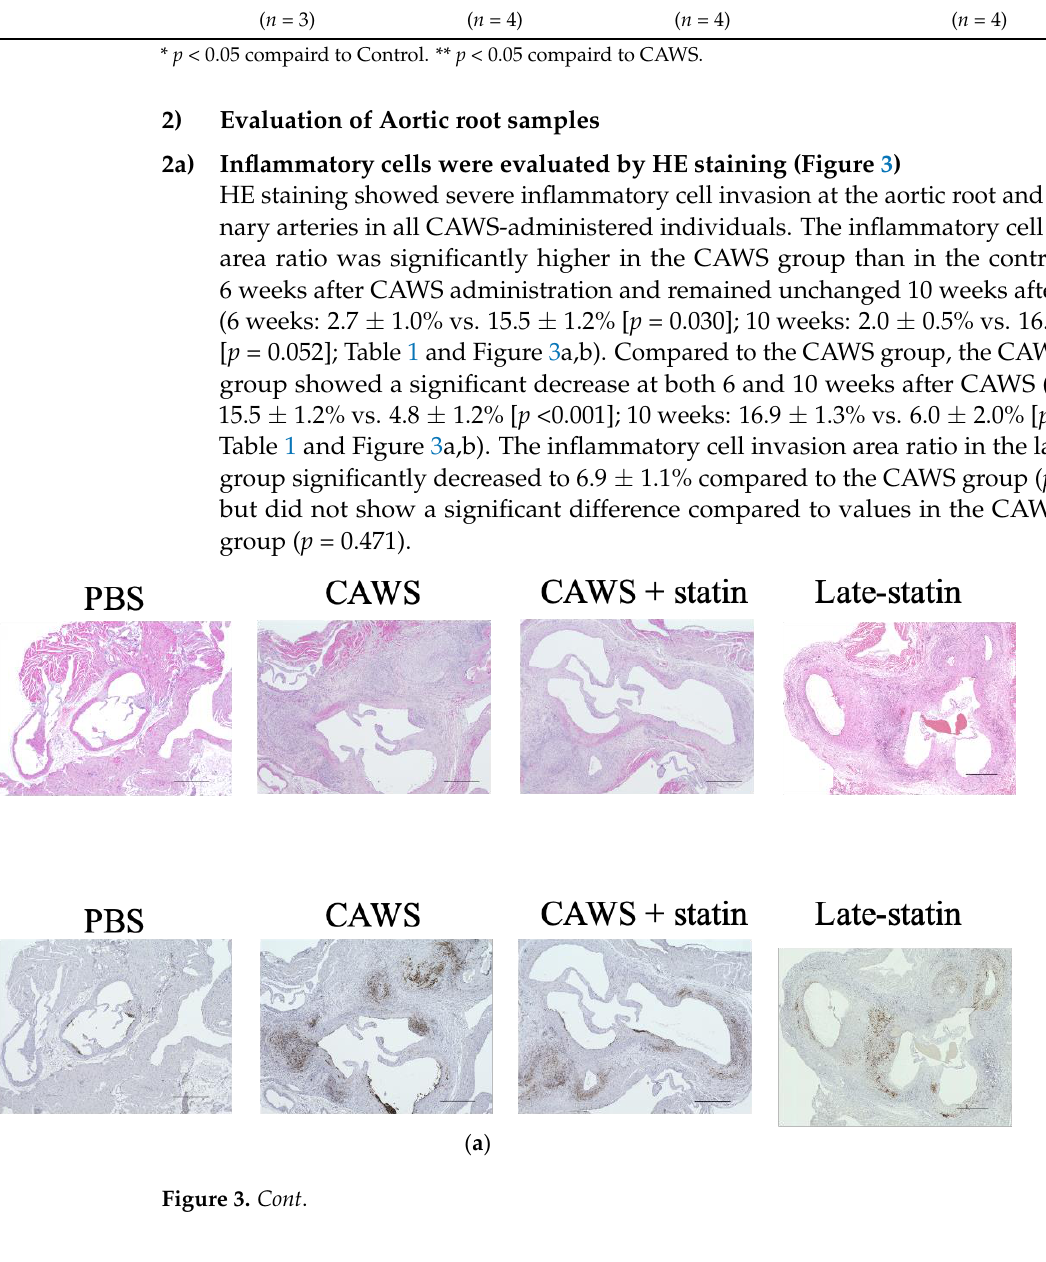
statin and CAWS+statin groups at 10 weeks, statins significantly inhibited atherosclerosis. The inhibitory effects were comparable between both groups. ( a ) Quantification of aortic plaque lesion coverage area ratios on the entire aortic surface. ( b ) Total aortic plaque coverage ratios. Compared to the CAWS group, the CAWS + statin group had a decreasing trend after 6 weeks of CAWS administration and a significant decrease 10 weeks after CAWS